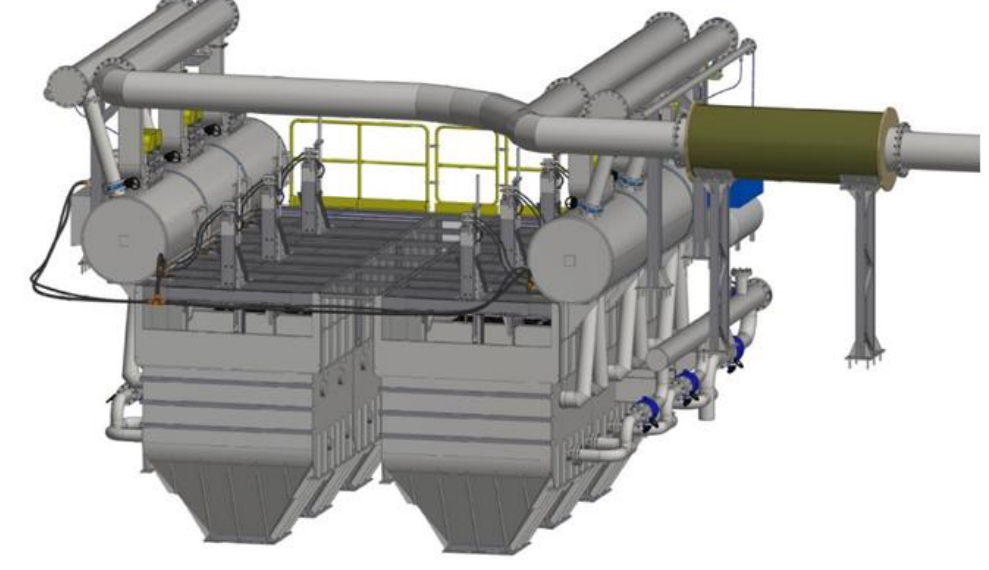
Figure 1. Pulsating jig.